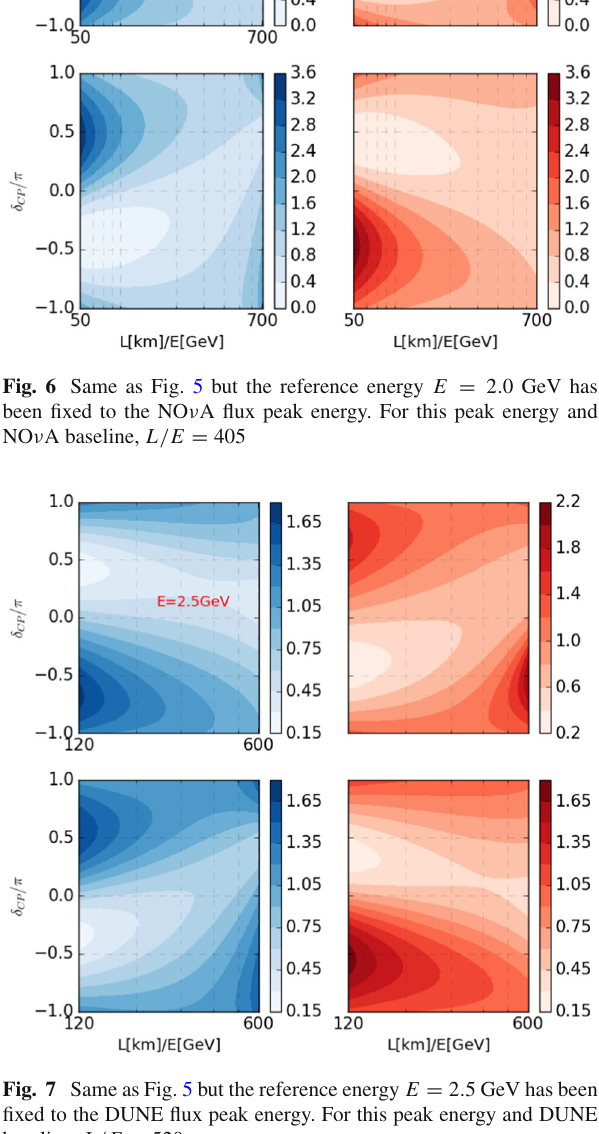
imum. T2K started taking data in 2009 and until 2019 release of results, these [10,11,13] correspond to 14 . 9 × 10 20 ( 16 . 4 × 10 20 ) protons on target (POT) in neutrino (anti- neutrino) mode. The NO ν A detector [9] is a 14 kt totally activescintillatordetector(TASD),placed810kmawayfrom the neutrino source at the Fermilab and it is situated at 0 . 8 ◦ off-axis of the NuMI beam. The flux peaks at 2 GeV, close to